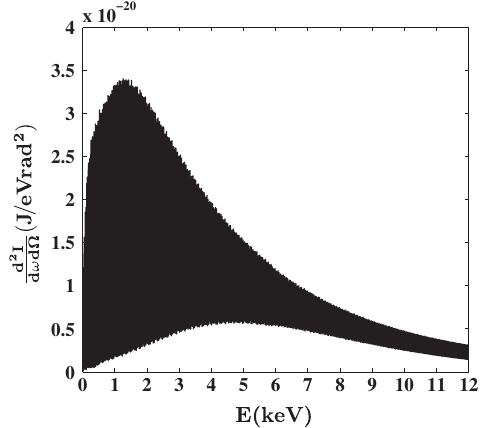
FIG. 5. The spectral intensity per solid angle along the þ x axis radiated by an electron scattering with a linearly polarized laser pulse. All of the calculation parameters are the same as those in Fig.